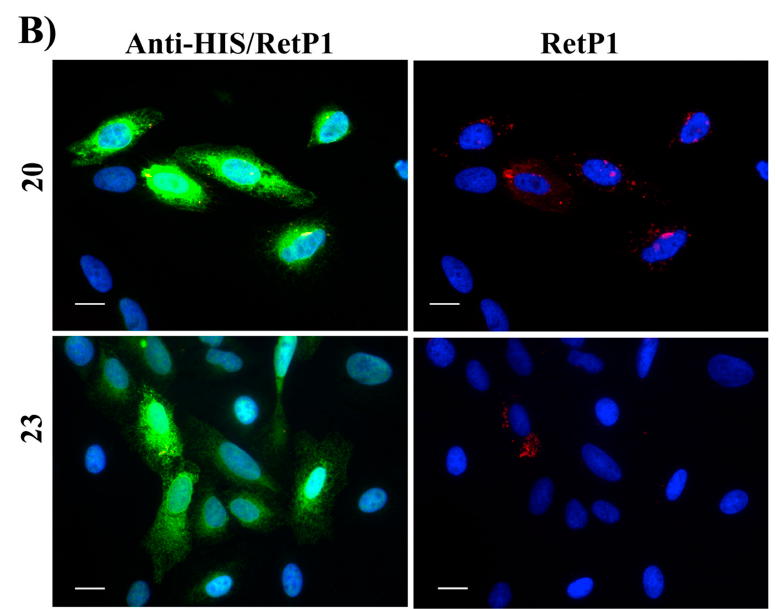
Figure 17. Subcellular localisation of hRHO P23H His-Tag in the presence of tested compounds: 7 and 13 ( A ); 20 and 23 ( B ). 13 and 20 were tested at 10 µM, whereas 7 and 23 at 20 µM. Anti-His/RetP1: Merged image of RetP1 staining (red) and Anti-His Tag binding total rhodopsin staining (His Tag expressed at the C-terminus of rhodopsin, intracellular, post-permeabilisation with 0.1% Triton; green). RetP1: Anti-rhodopsin antibody (extracellular N-terminus antibody, incubation prior permeabilisation, red) staining only the protein exposed on the cell membrane. Nuclei were stained with DAPI (blue). Scale bars: 10 µm. Molecules 2020 , 25 , x FOR PEER REVIEW